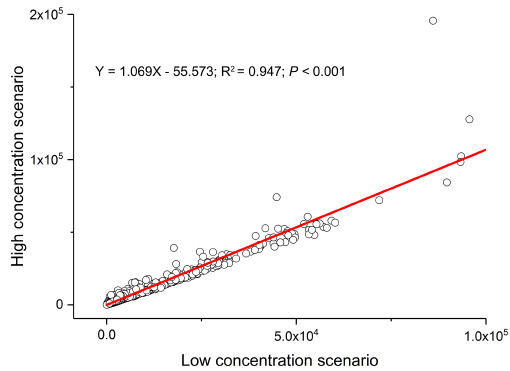
Figure 2. Relationship of the pathway degrees for invasive plant species (IPS) in protected areas (PAs) between low- and high-gas- concentration